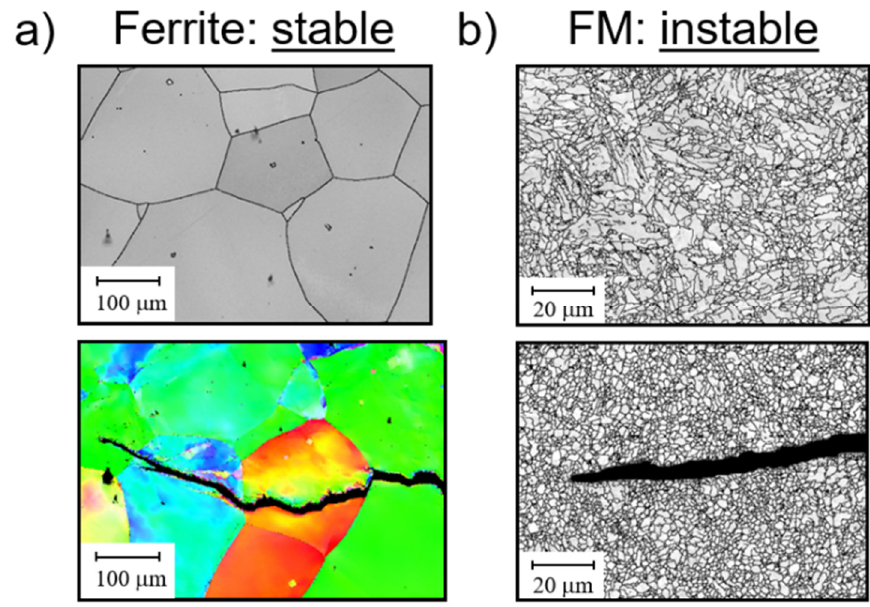
Figure 5. Comparison of grain structure in the initial state and in the vicinity of cracks induced by TMF loading in ( a ) a microstructurally stable ferritic (EBSD-image) and ( b ) an unstable ferritic-martensitic P91 [13] steel (SEM image).